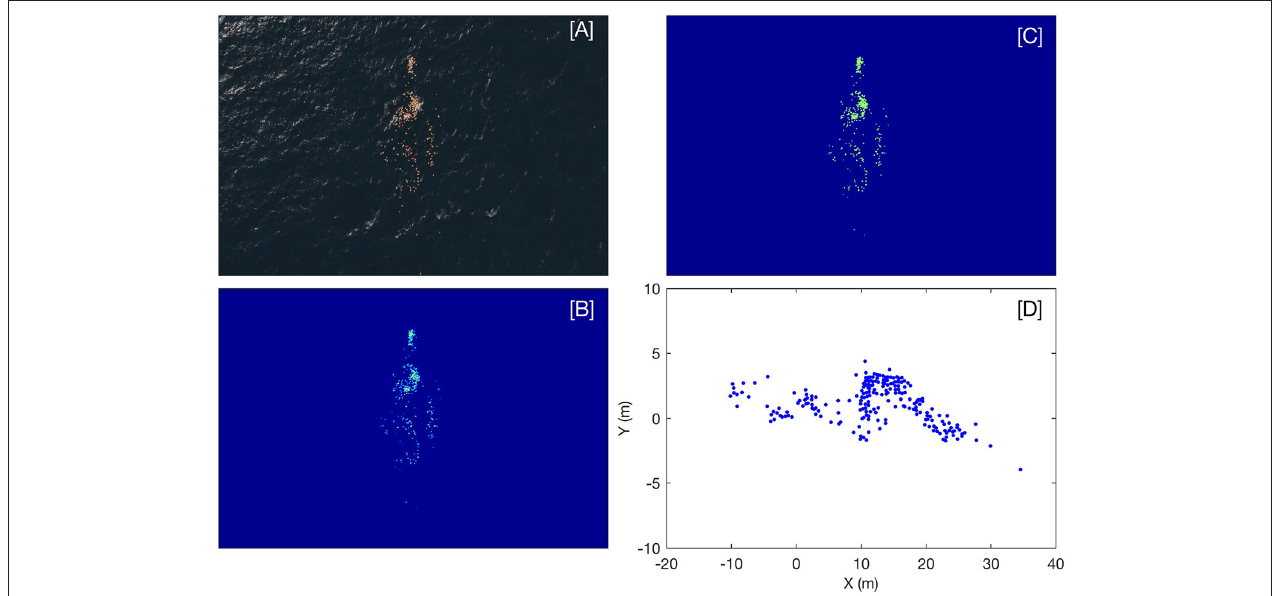
FIGURE 4 | (A) A raw RGB image excerpt showing the patch of bamboo plates. (B) A grayscale image produced after the color filtering step (see Equation 1 in section 2.4.1) clearly separates the patch of plates from the background and removes sun glitter. (C) The binary image (plates = 1 and background = 0) that results after the thresholding step. (D) The rectified patch of plates, with the major axis oriented along the x-axis due to lack of heading data.